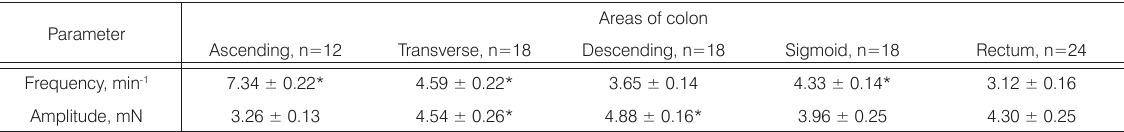
Table 1. Frequency and amplitude of spontaneous contractile activity of SM preparations, dissected from ascending colon, transverse colon, descending colon, sigmoid colon, and rectum. The comparison involved the values of each parameter of spontaneous SM contractions obtained from the different areas of the colon and was made with reference to the respective smallest value; * P < 0.05.